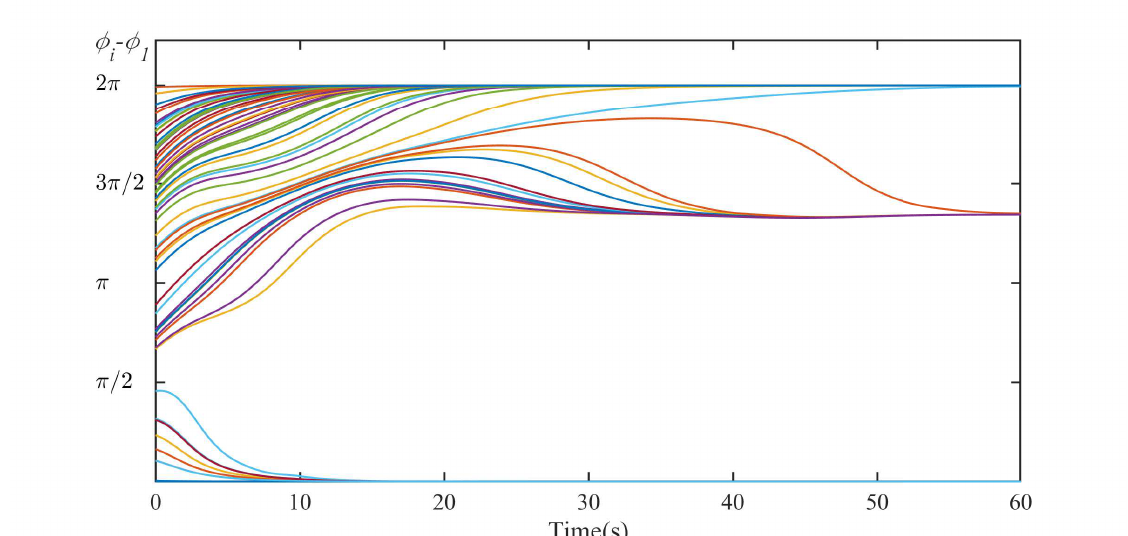
Figure 13. The simulation results are shown for the first individual’s third image using the first individual’s H ij function, which is a particular stable 2-cluster partition. Each curve represents the phase difference φ i − φ 1 .